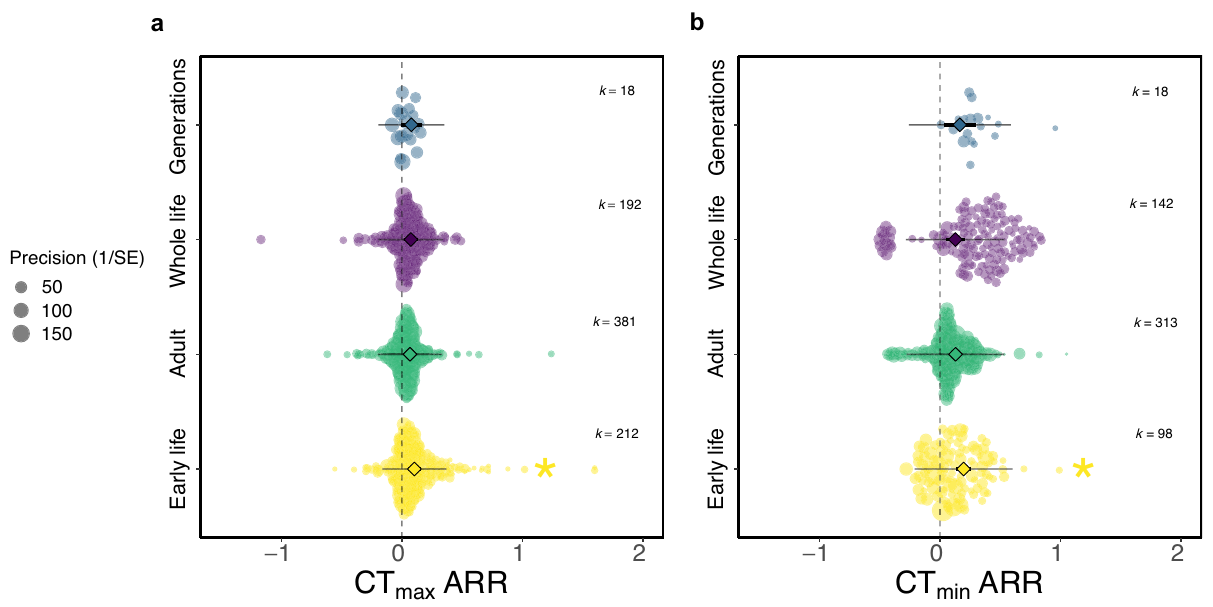
Fig.2|Theeffectofacclimationlifestageonacclimationresponseratio(ARR)forcriticalthermallimits,aCT max (k=803)andbCT min (k=571). Earlylifeisde fi ned astheeggornymphstage forhemimetabolous(non-metamorphosising)insectsandtheegg,larvalorpupalstageforholometabolous(metamorphosising)insects. 95% con fi dence intervals (95% CIs) are depicted in heavy black lines (often hidden by the mean data point, depicted by a diamond symbol), prediction intervals in thin black lines. The size of each data point is proportional to the precision of the study (1/SE (Standard Error)). k=number of effect sizes per group. Asterisk indicates that 95% CIs do not overlap, comparisons are made with the adult